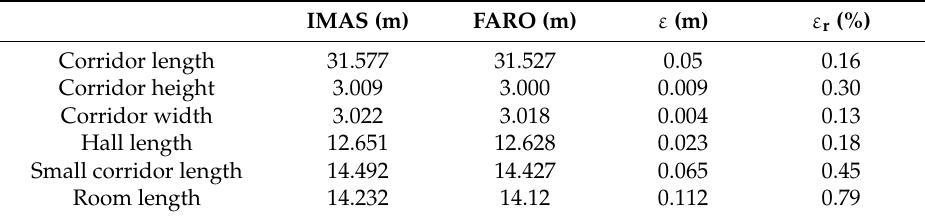
Table 2. Quality evaluation of the 3D point cloud obtained with the IMAS: geometric parameters of characteristic features.